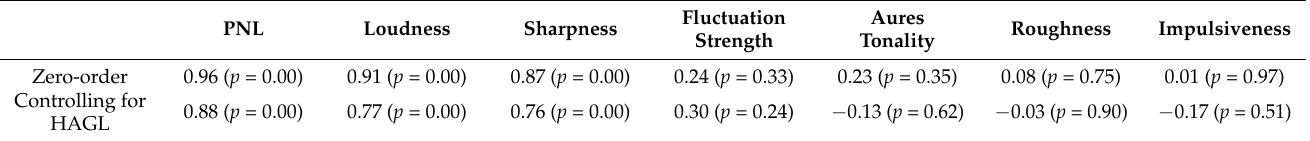
Table 4 . Zero-order and partial correlation coefficients (controlling for height above ground level (HAGL)) between PNL and the SQMs (loudness, sharpness, fluctuation strength, Aures tonality, roughness and impulsiveness) and perceived annoyance. p -value shown in brackets.